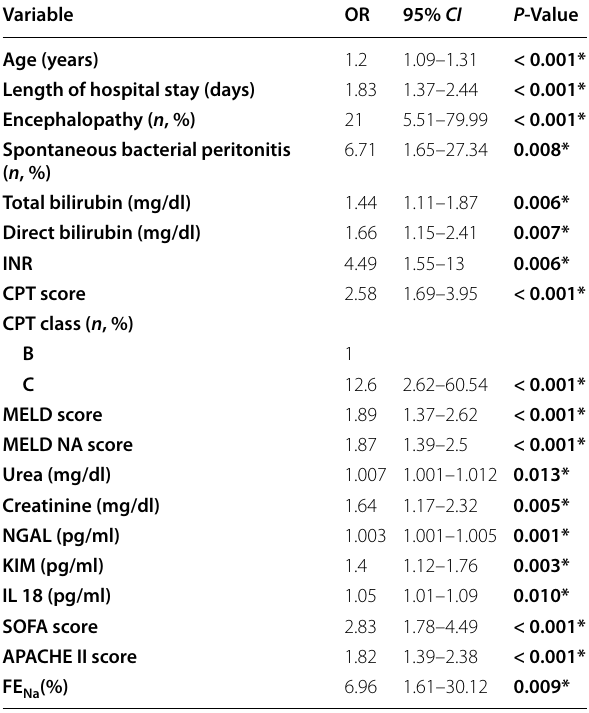
Table 3 Best fitting simple linear regression predictors of renal impairment in cirrhotic patients